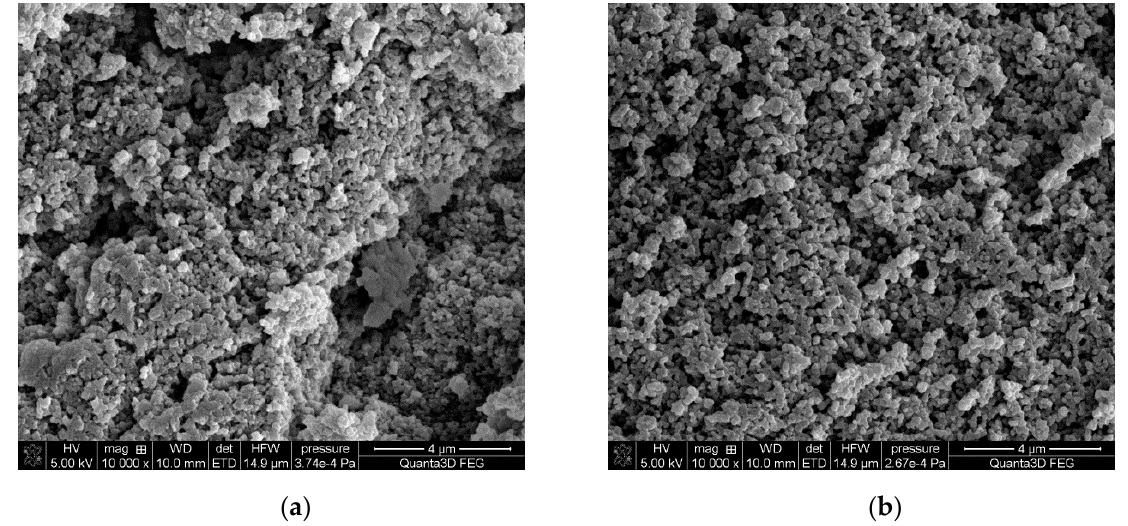
Figure 4. SEM images of cut ( a ) Purolite S 940, ( b ) Purolite S 950 after the Cu(II) ions sorption process.